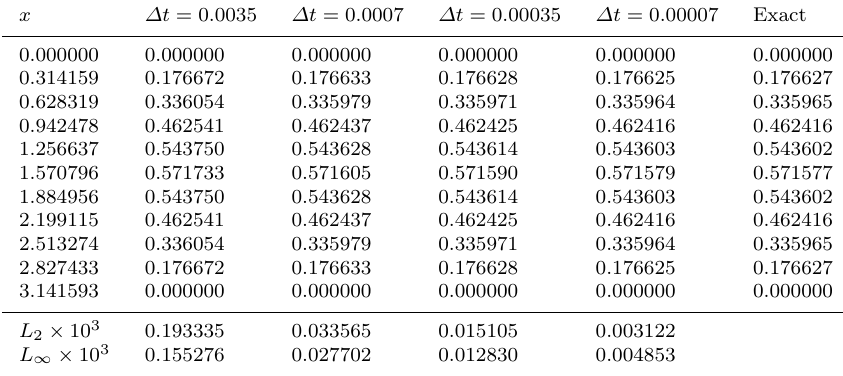
Table 3. The comparison of solutions and error norms of the diffusion problem for γ = 0 . 5, M = 40 and t f = 0 . 35. x